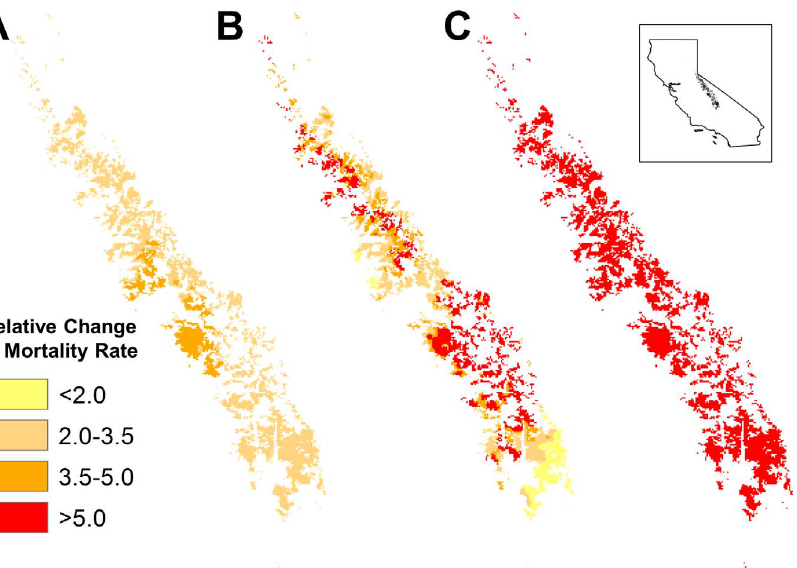
Figure 2. Projected Changes in Mortality Rate for predominantly Energy-Limited Sierra Nevada Conifer Forests (Hypothetical). Mapped projections of average relative changes in mortality rate for the years 2090 to 2099 for energy-limited coniferous forests ( $ 2450 m) of California’s Sierra Nevada, using exponential models and the GFDL A2 emissions model. Elevations generally increase from left to right. (A) Changes in mortality when absolute changes in deficit ( D a ) are used as a predictor. (B) Changes in mortality when relative changes in deficit ( D r ) are used as a predictor. (C) Changes in mortality when absolute changes in temperature (T a ) are used as a predictor. Other emissions scenarios gave qualitatively similar results (Figs. S6 to